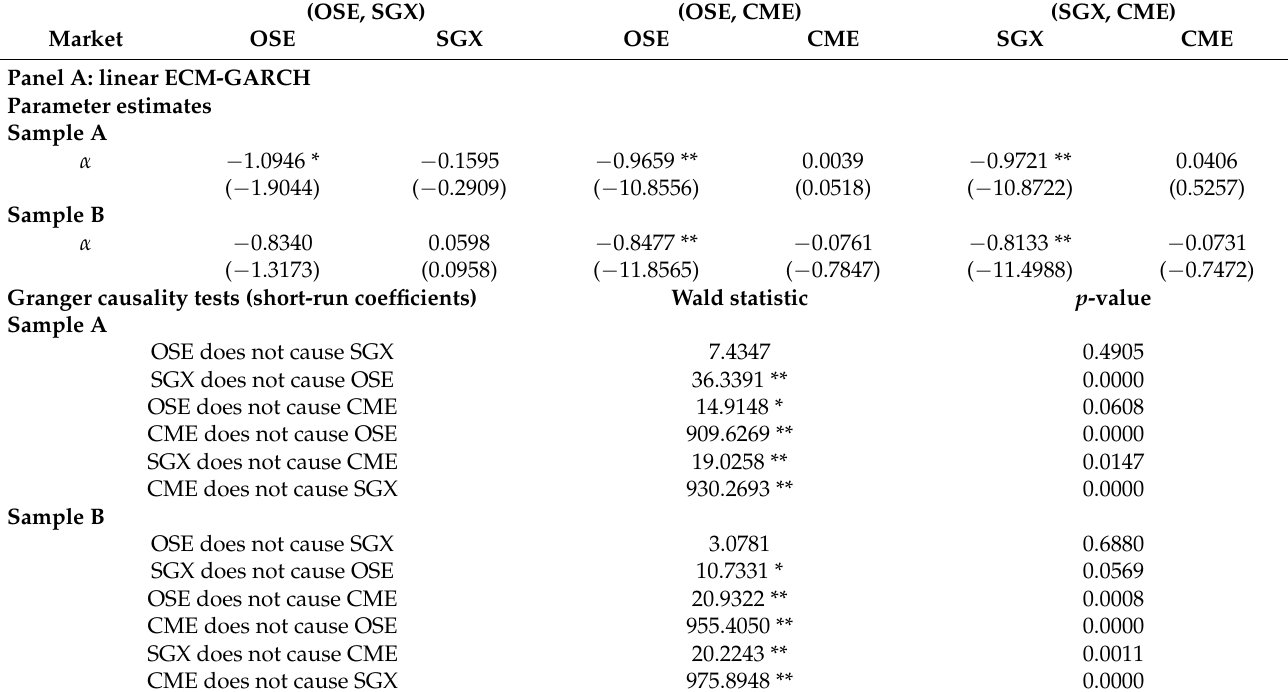
Table 4. Estimation results: The cross-border futures price